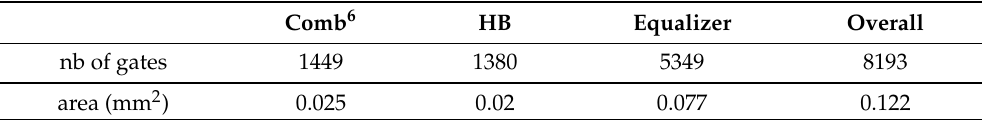
Table 4. Decimator gate count and